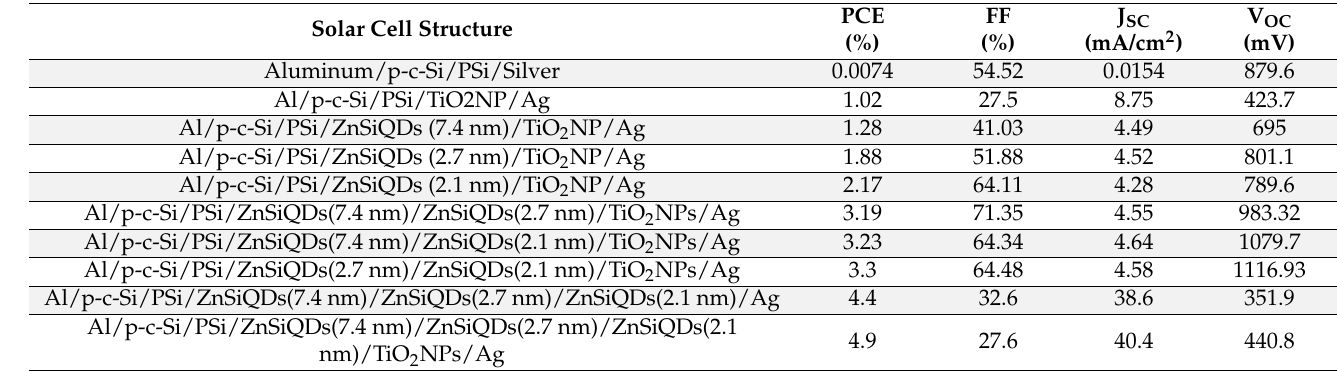
Table 3. Performance parameters comparison of the studied solar cells. Solar Cell